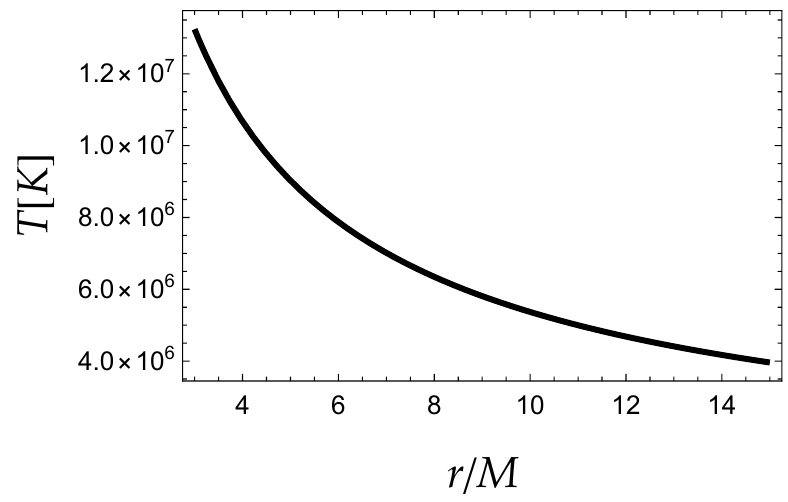
Figure 1. Temperature of the disk versus radial distance assuming M = 30 M (cid:12)